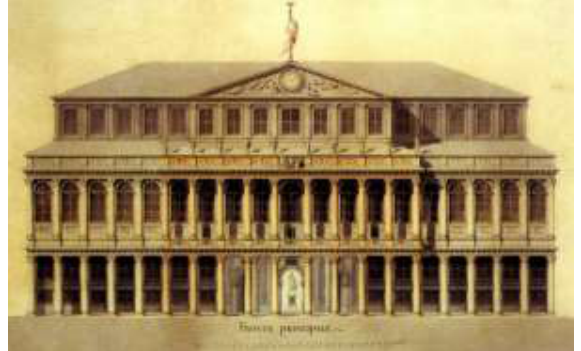
Figure 4. Alessandro Antonelli, National Parliament, trasversal